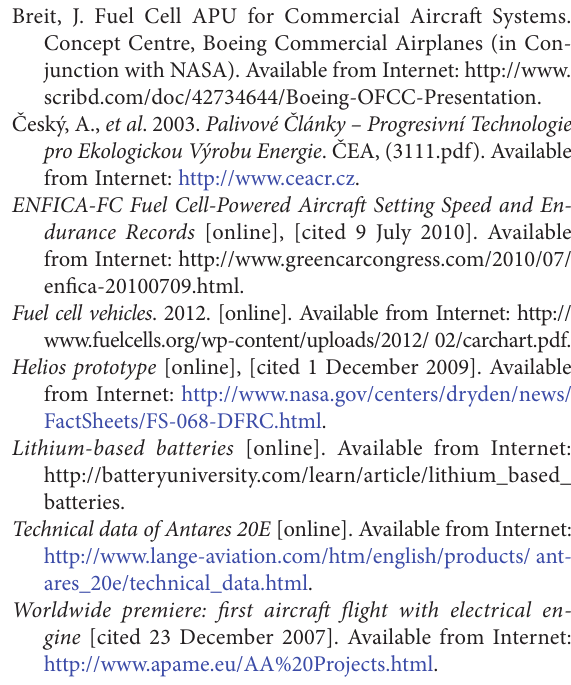
Breit, J. Fuel Cell APU for Commercial Aircraft Systems. Concept Centre, Boeing Commercial Airplanes (in Con- junction with NASA). Available from Internet: